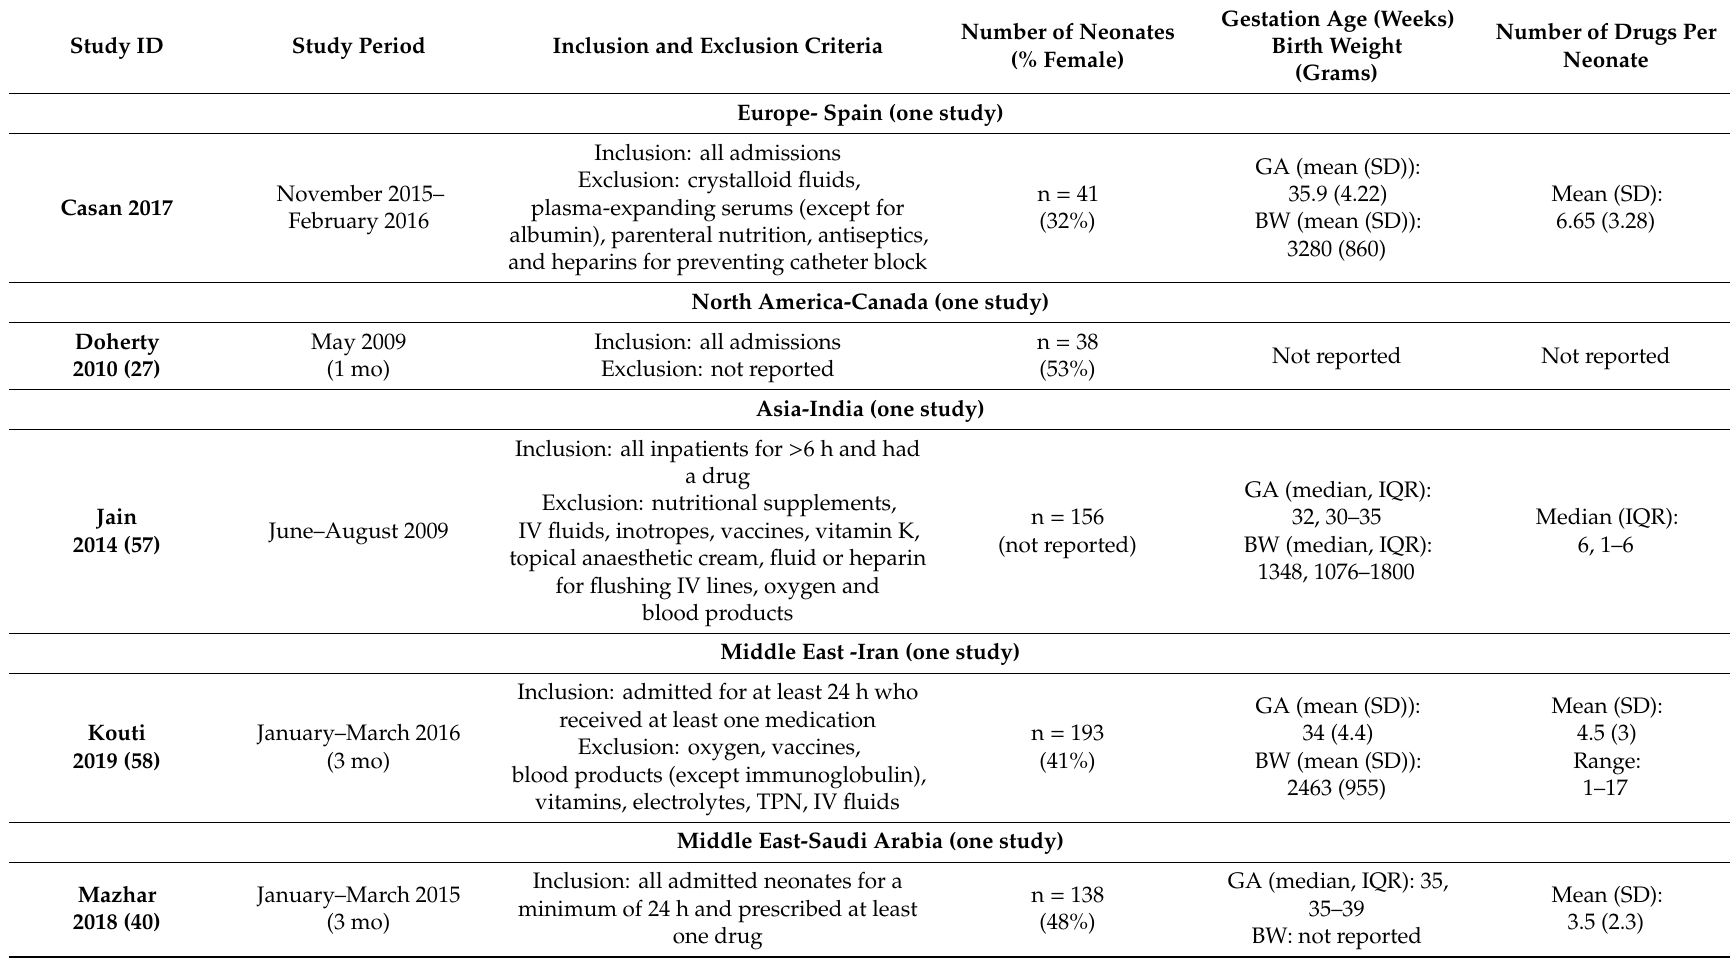
Table A9. Studies of drug utilization on o ff -label and / unlicensed drugs only (6